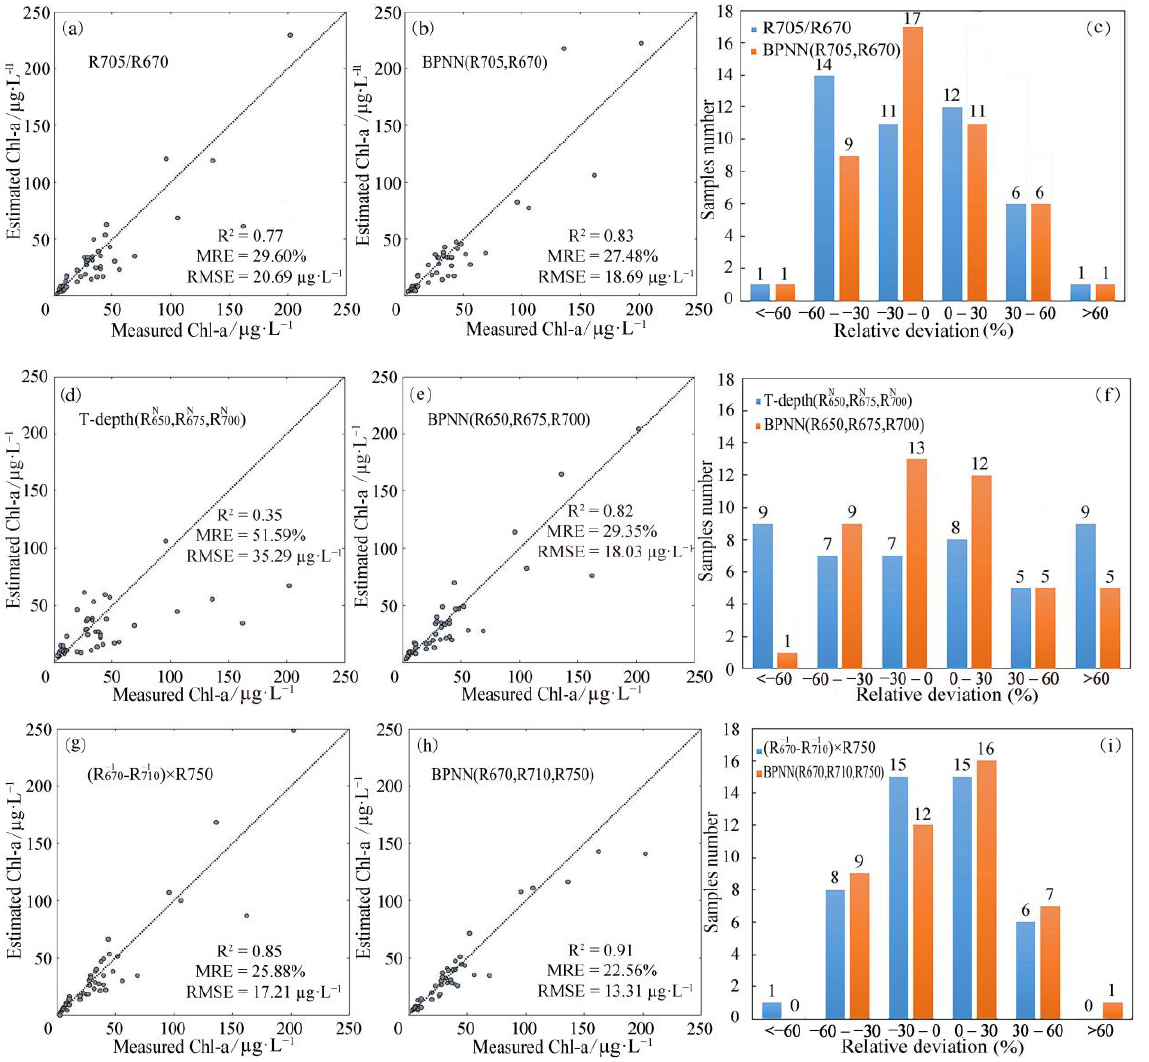
Figure 3. Scatter plot (the dotted line is the 1:1 line) for (a) The ratio model (R705/R670), (b) The BPNN model (R705, R670), (d) The t-depth statistical model, (e) The BPNN model (R650, R675, R700), (g) The three-band statistical model and (h) The BPNN model (R670, R710, R750), and relative deviation distribution between the measured values and retrieval values for (c) The two-band combination models, (f) The T-depth statistical model and corresponding BPNN model and (i) The three-band combination models for chlorophyll-a (Chl-a) concentration.